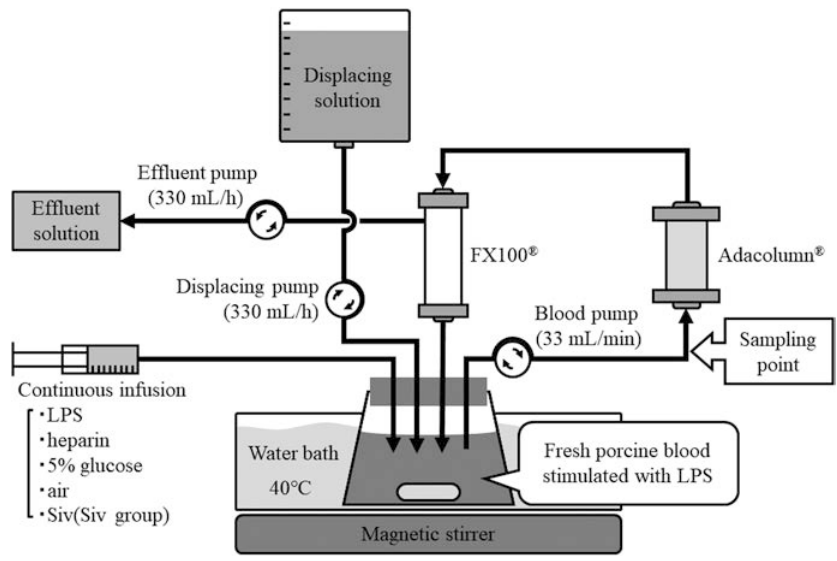
Figure 1 Schematic diagram of the blood preparation and treatment processes. Fresh porcine blood stimulated with LPS was maintained in a reservoir at 40°C. In addition to LPS, heparin, 5% glucose, and air were added to ensure that leukocytes survived for 24 h. The Siv treatment group received continuous administration of sivelestat sodium hydrate. The system was equipped with an Adacolumn ® (JIMRO Co. Ltd., Takasaki-shi, Gunma, Japan) and an FX100 ® instrument (Fresenius Medical Care Japan, Tokyo, Japan). Continuous hemofiltration was performed to maintain electrolyte and pH levels. Blood was collected at the entrance of the primary column. CHF: continuous hemofiltration; LPS: lipopolysaccharide; Siv: sivelestat sodium